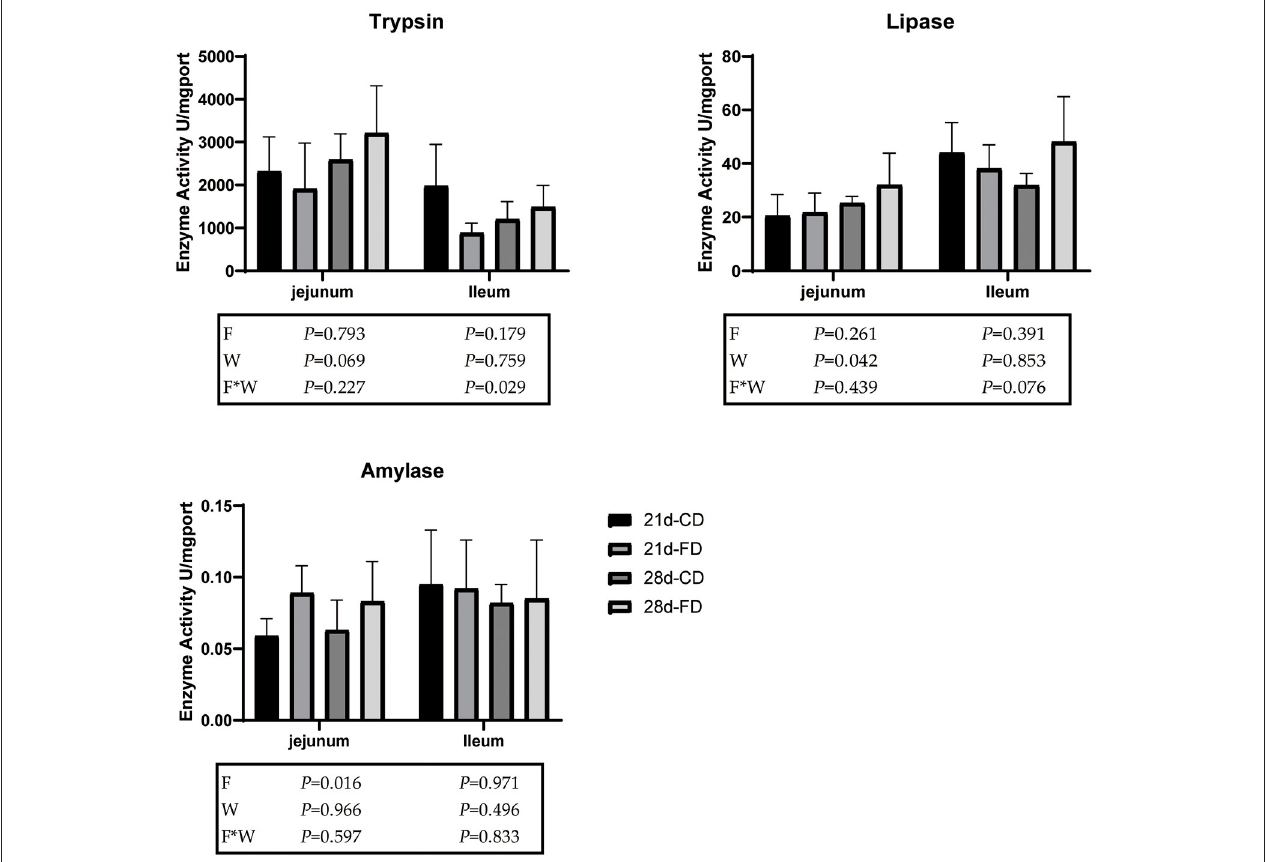
FIGURE 2 | The effects of fermented diet and weaning age on digestive enzyme activity. 21d-CD, 21-day-old weaned piglets fed the control diet. 21d-FD, 21-day-old weaned piglets fed the fermented diet. 28d-CD, 28-day-old weaned piglets fed the control diet. 28d-FD, 28-day-old weaned piglet fed the fermented diet. F, the main effect of fermented diet. W, the main effect of weaning age. F*W, the interaction effect between fermented diet and weaning age. Values are presented as the mean ±